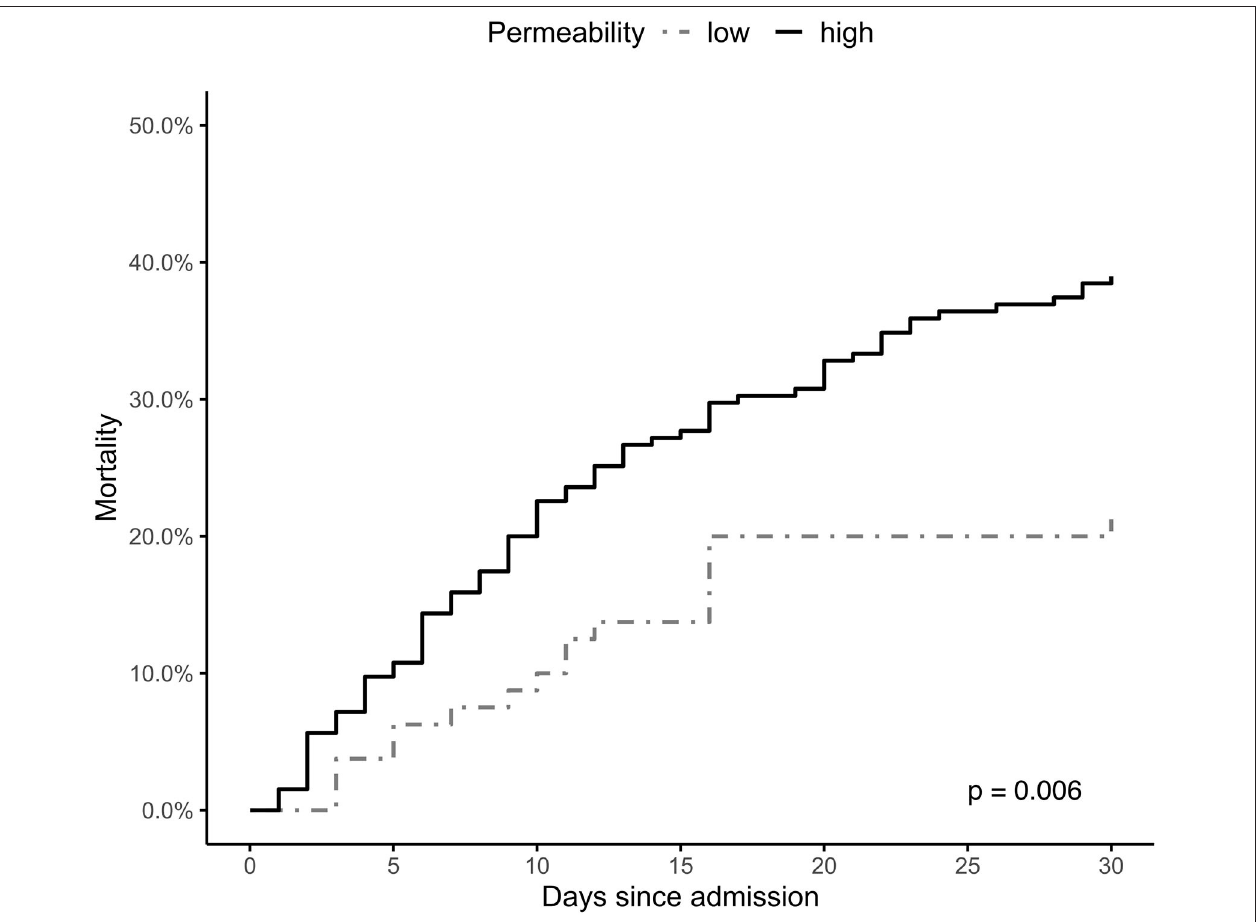
FIGURE 3 | Hb-stratified Kaplan-Meier estimates of the probability of 30-day mortality among patients successfully resuscitated from cardiac arrest. Group A = a decrease in hemoglobin (Hb) levels > 1 g/dL within 12h after return of spontaneous circulation (ROSC); Group B = increase in Hb levels or a decrease of < 1 g/dL Hb within 12h after